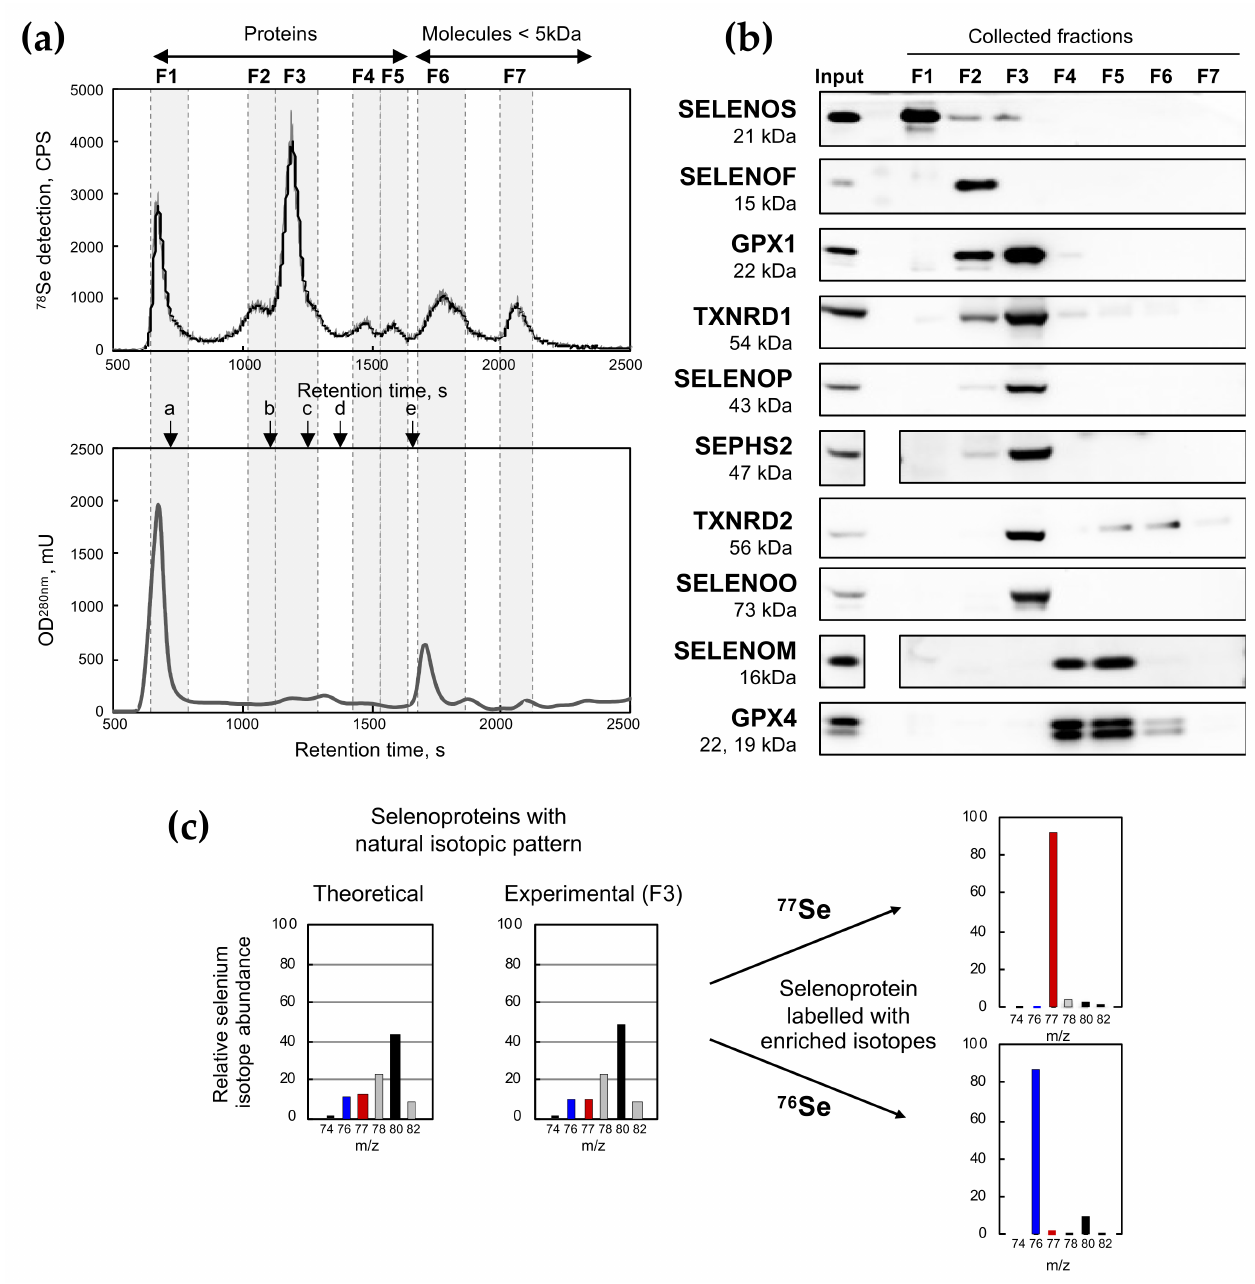
Figure 1. Fractionation of selenoproteins and selenocompounds of HEK293 cells by SEC-ICP MS. ( a ) Cellular extracts of HEK293 cells grown in Unsup + 100 nM of selenium (sodium selenite with natural isotopic pattern) were analyzed by SEC-ICP MS. The chromatographic profiles for 78 Se and OD 280nm are represented in black and gray lines, respectively. The elution time of the selected calibration standards is shown in the bottom panel (a, thyroglobulin; b, transferrin; c, Mn-SOD; d, myoglobin; e, selenomethionine). The selenium eluted in seven fractions (referred to as F1 to F7) as noted from the 78 Se chromatographic profile. Elution time and molecular weight range of these fractions are reported in Table 1. ( b ) The collected fractions F1 to F7 were then analyzed for the presence of 10 selenoproteins (SELENOS, SELENOF, GPX1, TXNRD1, SELENOP, SEPHS2, TXNRD2, SELENOO, SELENOM, and GPX4) using specific antibodies by western immunoblotting in comparison with the raw cellular extract. ( c ) Representation of selenium isotopic pattern in fraction F3 from fractionation SEC-ICP MS performed in panel ( a ). Cellular extracts of HEK293 grown in Unsup +100 nM of selenium ( 76 Se or 77 Se enriched selenite) were also analyzed by SEC-ICP MS. The isotopic enrichment of fraction F3 is illustrated in the two right